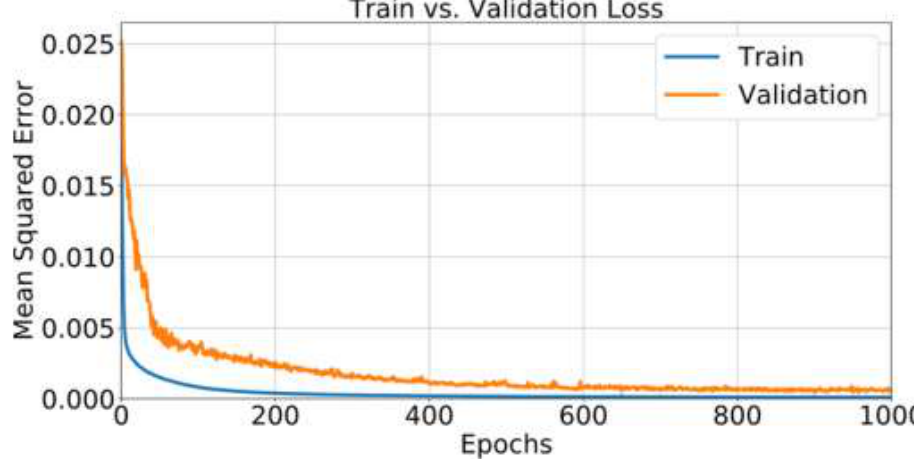
Figure 5. The training and validation loss values versus the mean square error. After model testing and validation, the hyper-parameters are computed. The structure of the CNN model is displayed in Table